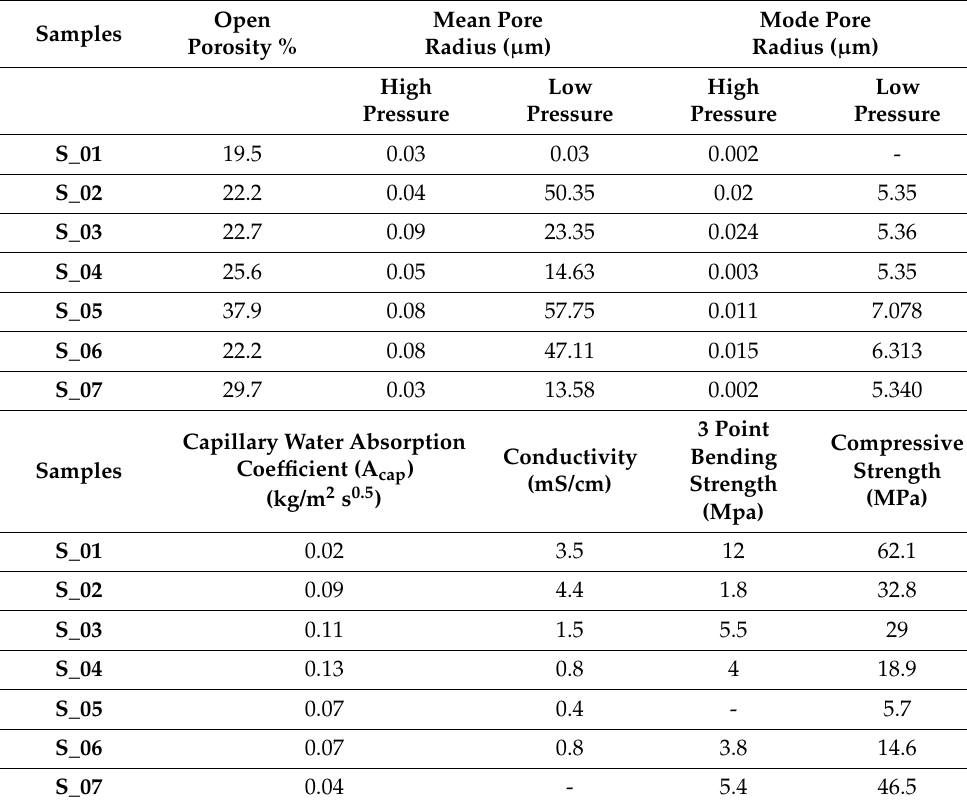
Table 1. Physical and mechanical properties of all seven natural stone samples of the marly limestone of the Hellenistic theater of